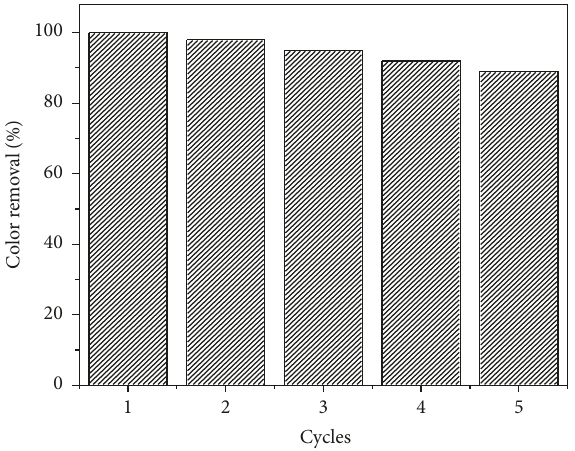
Figure 8: The result of five cyclic tests of MB discoloration. The experimental conditions used were MB 12ppm, spent cathode 4 cm 2 , and 0.1M H 2 O 2